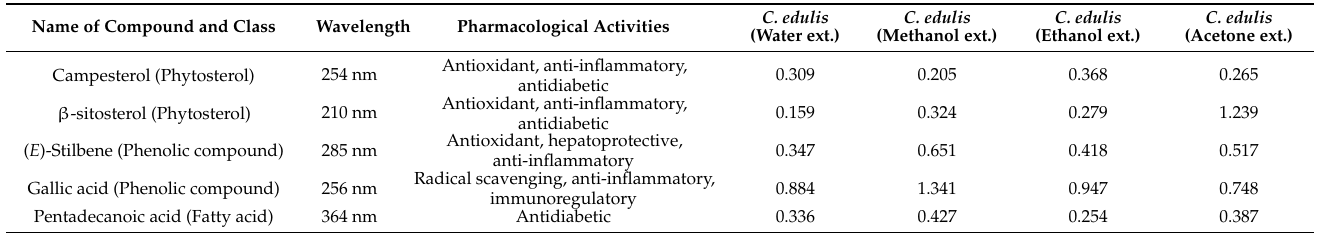
Table 3. Phytochemicals’ concentration of different extracts from Caralluma edulis measured by